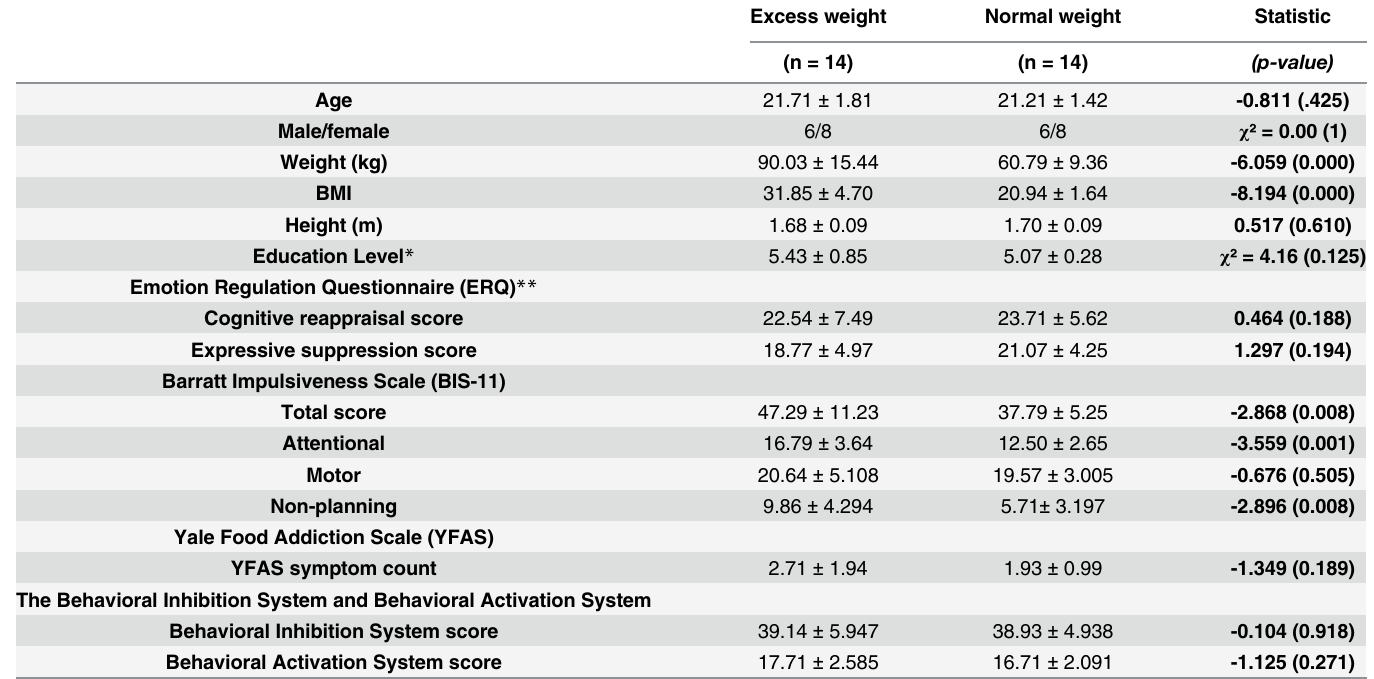
Table 1. Sample characteristics and behavioral measure